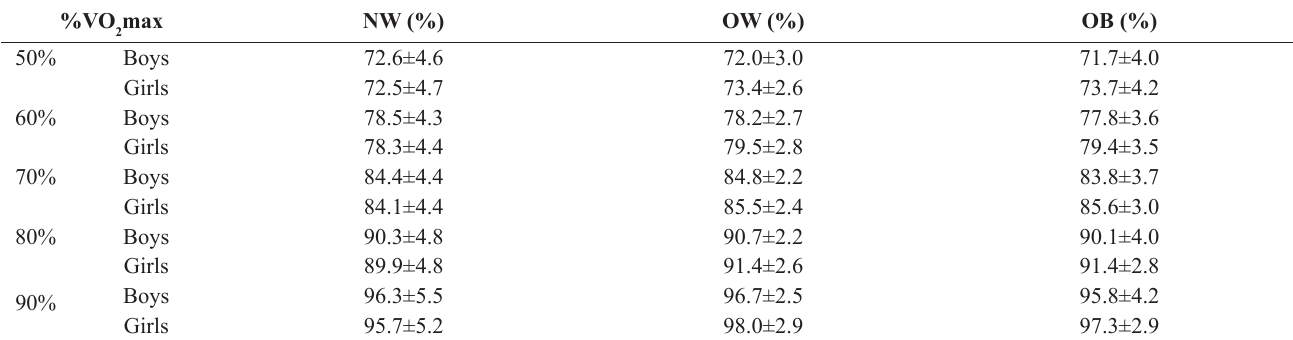
max in normal weight, overweight, and obese adolescents. 2